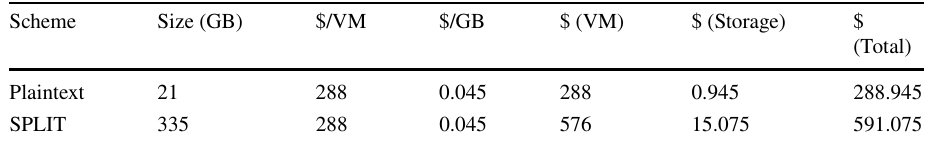
Table 1 Monthly dollar cost of Cloud platforms